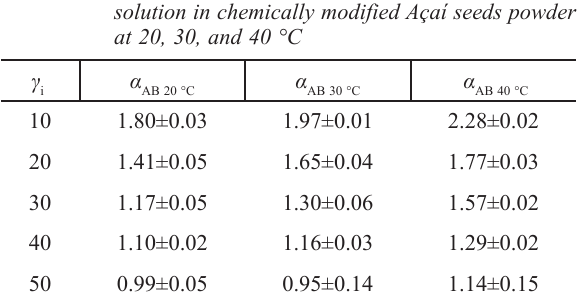
Table 6 – Selectivity factor for the biosorption of the binary solution in chemically modified Açaí seeds powder at 20, 30, and 40